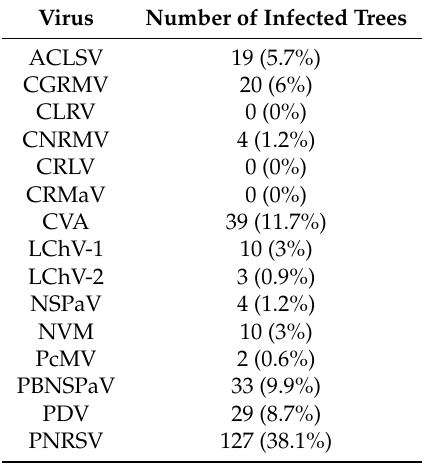
Table 3. Viruses identified during the survey in the National Clonal Germplasm